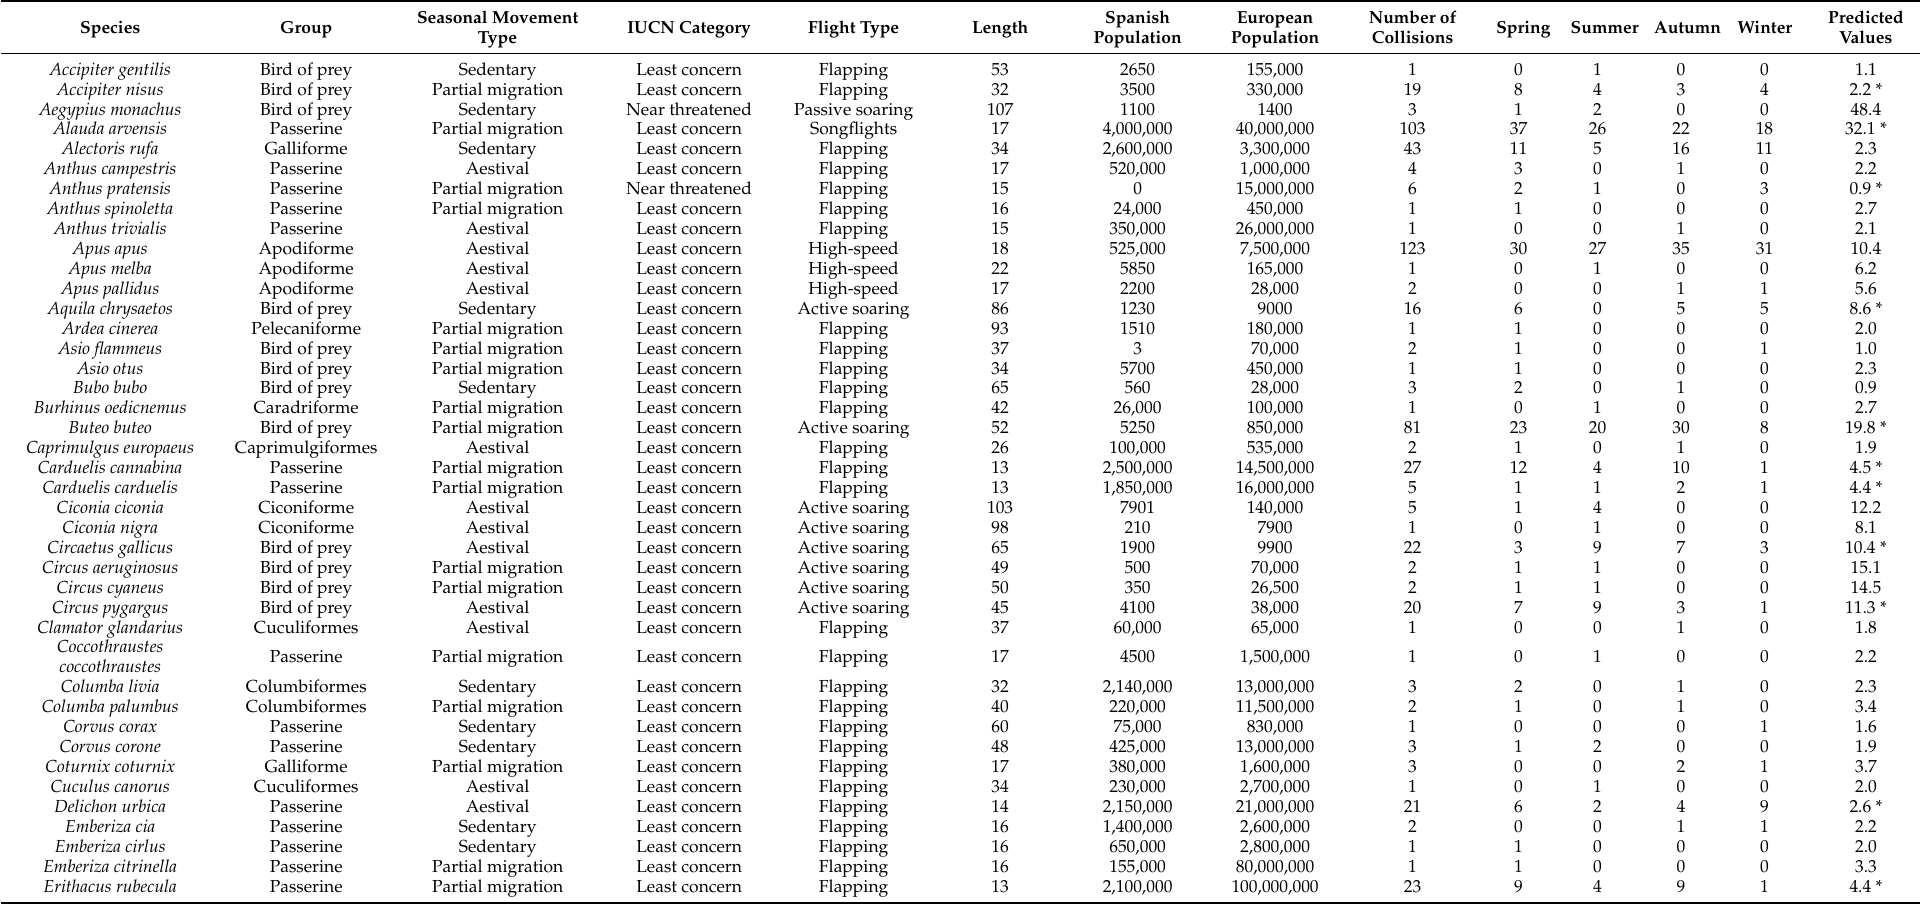
Table 1. Birds species that collided with wind turbines over 16 years (2001–2016) from two rescue centres in Spain. The Table shows the group, seasonal movement type, IUCN category, flight type, length, Spanish population, European population, the total number of collisions, collision seasonality, and predicted values of collisions obtained with the linear model including all the species. The 29 species used in the reduced dataset are indicated with asterisks beside the predicted values